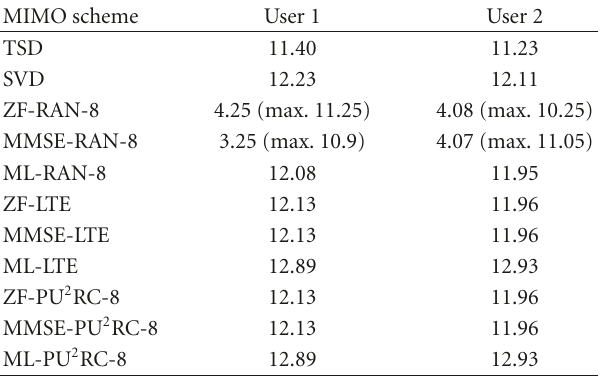
Table 2: Achieved rates for channel definition